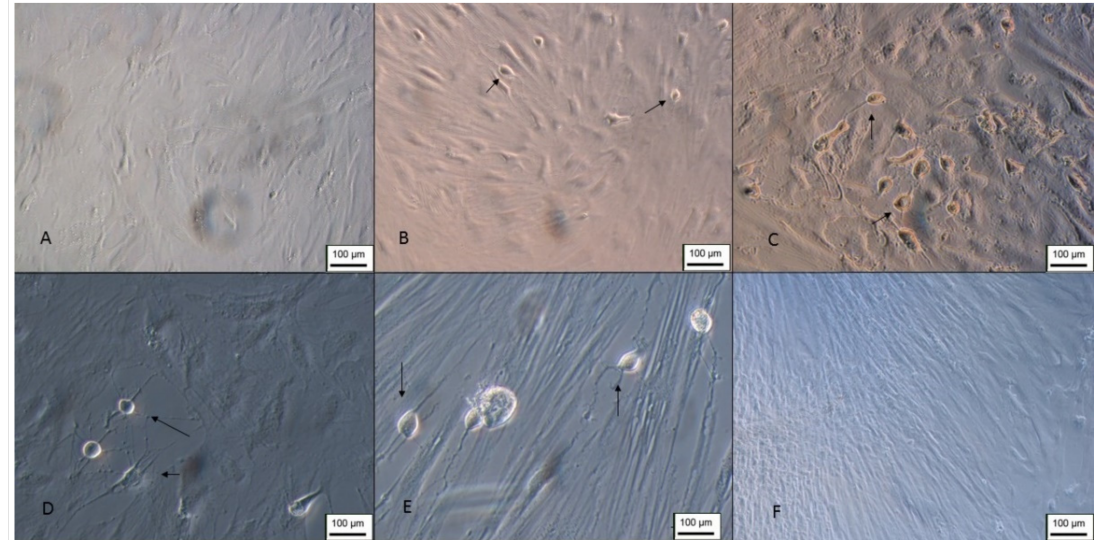
Figure 22. Differentiation in Schwann cells from Neural precursors. ( A ) Cells 4 days after induction (100 × ); ( B , C ) 8 days after induction (100 × ); ( D ) cells 10 days after induction (100 × ); ( E ) 10 days after induction (200 × ); ( F ) undifferentiated control—100 X (inverted optical microscopy). Scale bar, 100 µ m.